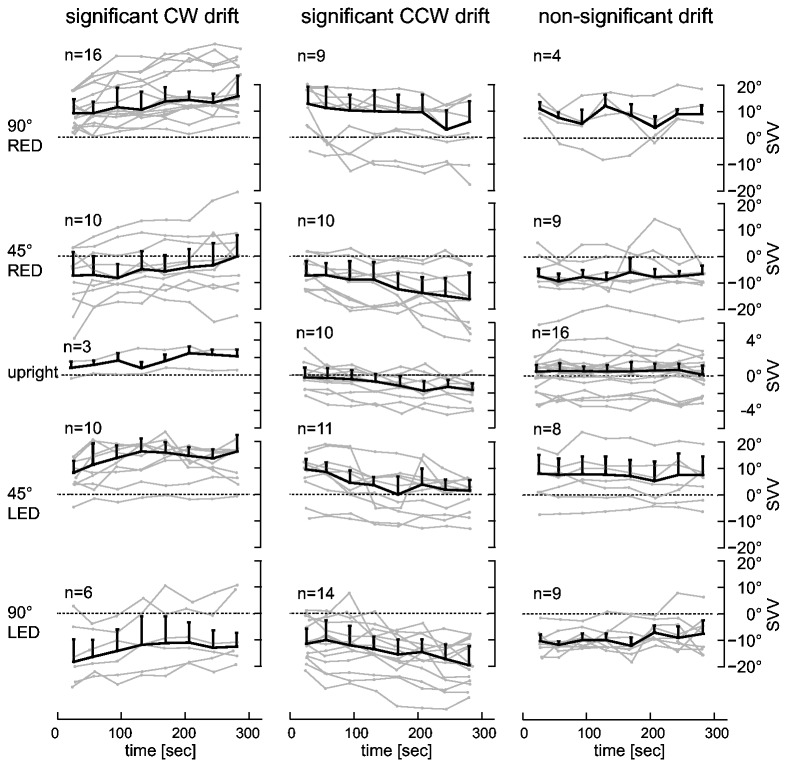
Individual (in grey) and median (in black) adjustment errors while roll-tilted are plotted against time.Traces with significant (p < 0.05) CW, significant CCW and non-significant drift while roll-tilted and in upright position are shown in separate columns, always indicating the number of subjects (n) that met the criteria for a given trial type. Note that for baseline upright trials the scaling along the y-axis differs from the roll-tilted positions. For a more detailed description see figure legend of Figure 2.